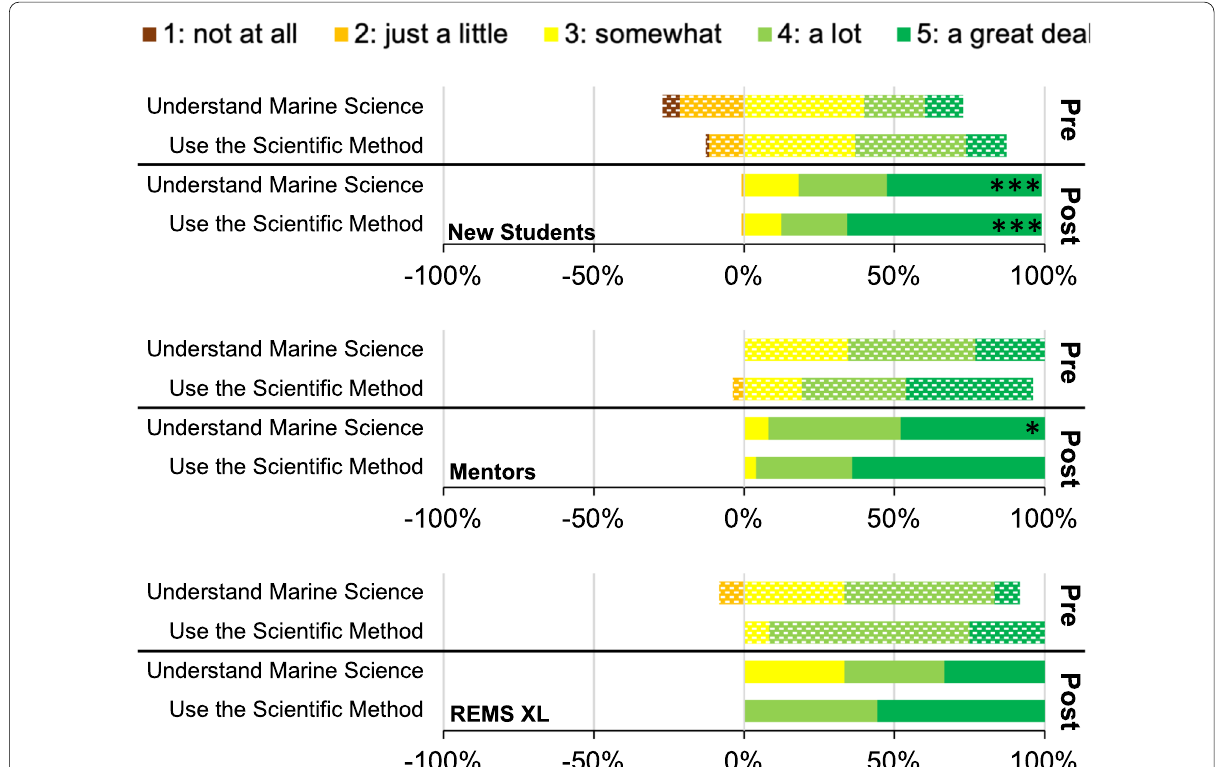
Fig. 18 Recognition: pre- and post-program recognition of self-efficacy. Student responses (New Students ( N (12)) to REMS survey prompts asking about confidence in their understanding of marine science and the ability to use the scientific method to conduct an experiment. Pre- and post-program differences were analyzed with a Mann–Whitney U -test. * p < 0.05. *** p <